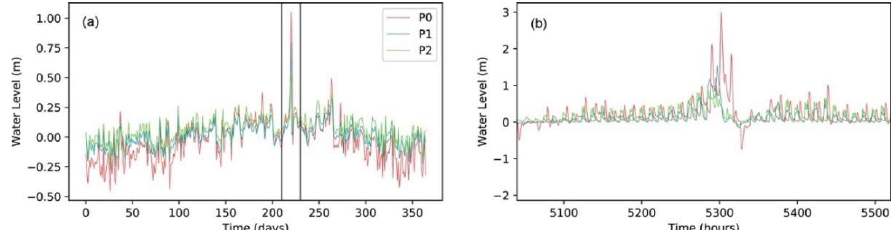
Figure 5. Differences in seawater level between S1 and S2 at the head of three estuaries. ( a ) The daily value for the entirety of 2019 and ( b ) the hourly values during the Typhoon Lekima period (marked with the thin, gray, dashed lines in the left panels).